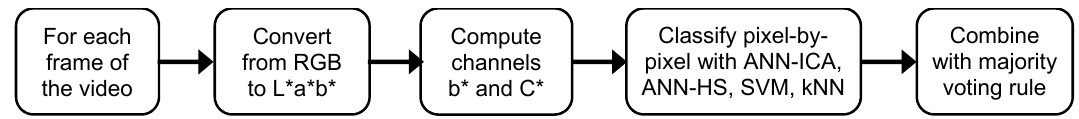
Figure 5. Diagram of the proposed algorithm for plum fruits segmentation. A sample video of the results can be accessed in: https://youtu.be/PoSrkz5PSJI.